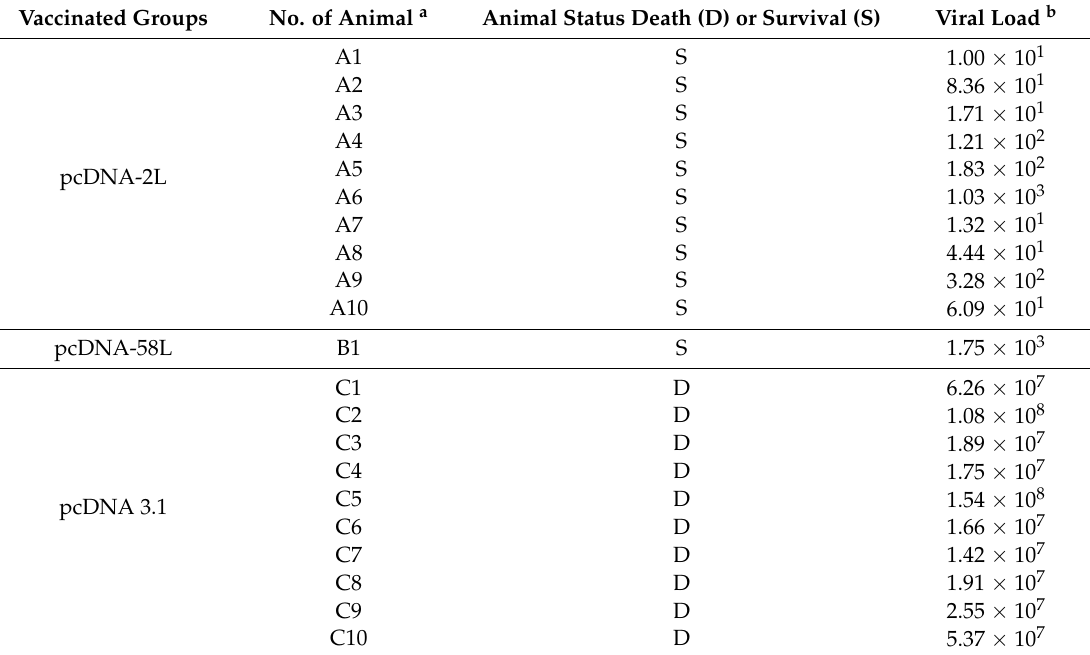
Table 2. ADRV viral load determined by qRT-PCR in the spleen tissues from the surviving and dead individuals of vaccinated Chinese giant salamanders after viral